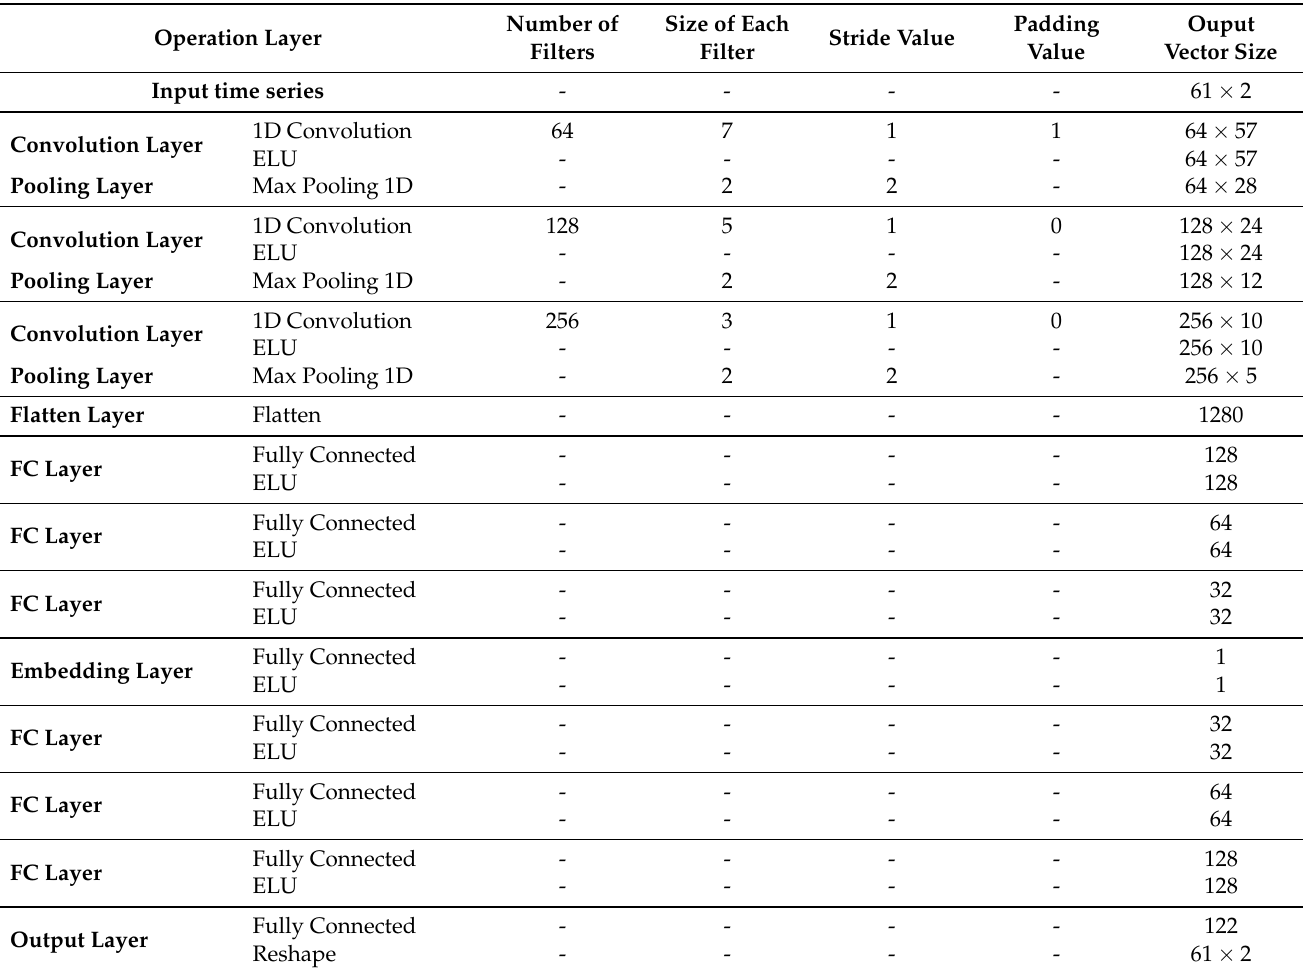
Figure 5. Convolutional Autoencoders Architecture for the processing of sequential data, such as SAR time series. The architecture used for our version of the CAE is detailed in Table 2. Table 2. Architecture of the Convolutional Autoencoder used in this